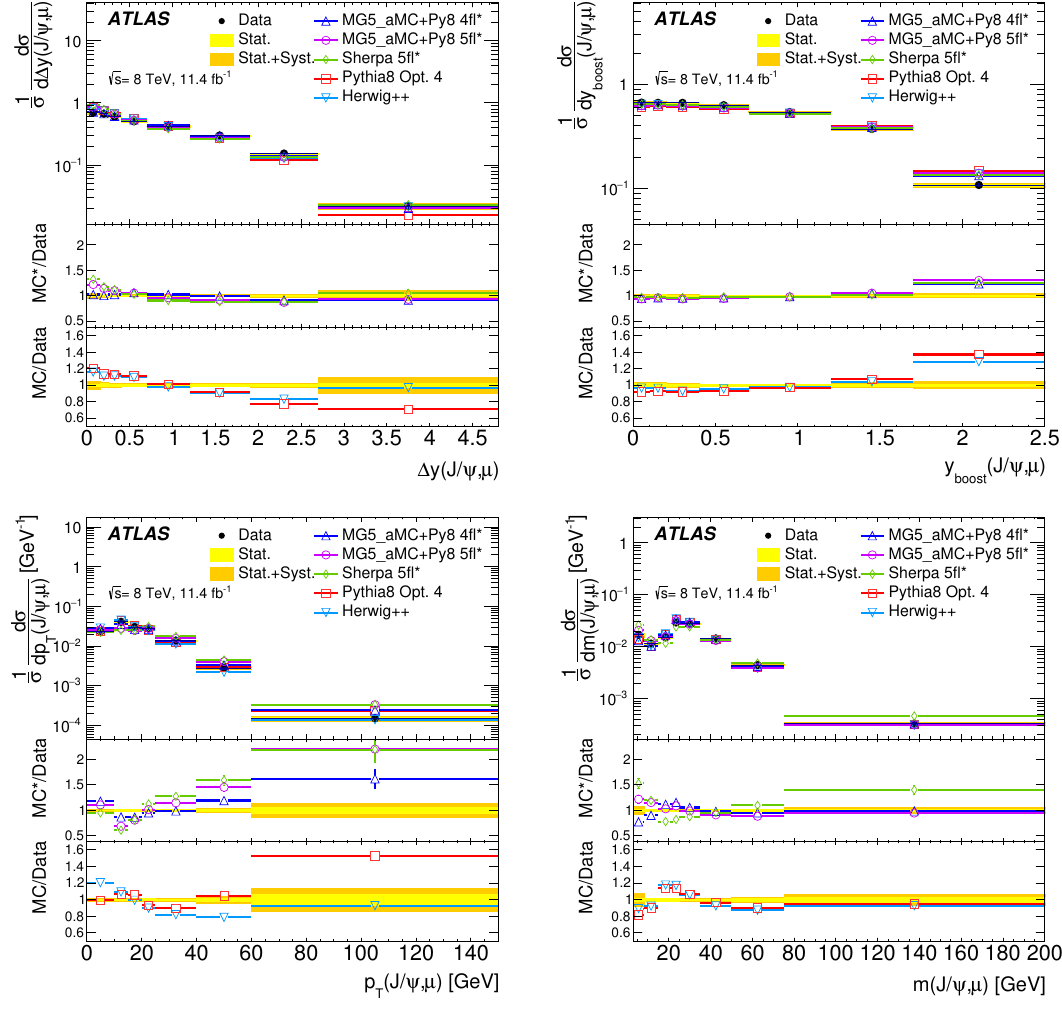
Figure 8 . Measured normalised di(cid:11)erential cross sections as a function of (cid:1) y ( J= ; (cid:22) ), y boost , p T ( J= ; (cid:22) ) and m ( J= ; (cid:22) ). Comparisons are made with predictions of Pythia8 and Herwig++ . MadGraph5 aMC@NLO + Pythia8 and Sherpa predictions are also compared having been cor- rected from the two- b -hadron production to the three-muon (cid:12)nal state via transfer functions (indi- cated with *). The Pythia8 \Opt. 4" gluon splitting parameter settings are described in table 1. The ratio to data of the MadGraph5 aMC@NLO + Pythia8 and Sherpa (middle pane), and Pythia8 and Herwig++ (bottom pane) are also